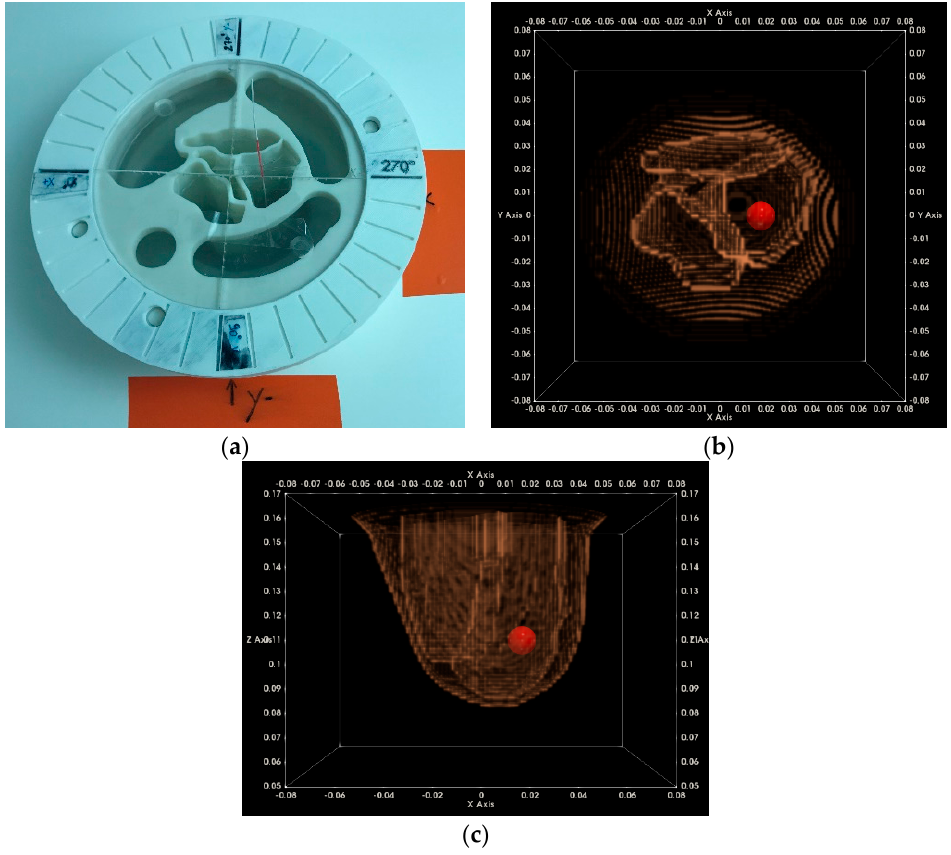
Figure 15. Experimental setup for the breast rotational position #1: ( a ) Photo—Top view of the breast phantom, installed on the examination table; ( b ) Schematic definition of the tumor location (red sphere with a 14-mm diameter, equal to the average diameter of the microlobulated tumor phantom), in the fibroglandular tissue of the breast (the outer surface of both the fibroglandular mold and the outer breast surface mold are depicted with orange color)—Top View; ( c ) Schematic definition of the tumor location in the fibroglandular tissue of the breast—Side